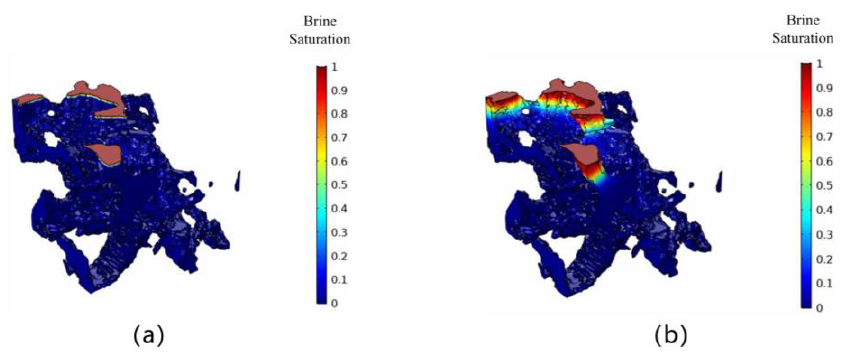
Figure 14. The tighter REV saturated with CO 2 ( a ) was initially saturated with brine in the near-inlet region with global target brine saturation of 0.05, ( b ) as prepared for the CO 2 –brine imbibition process over a range of target saturation from 0.2 to 0.9 with initial model conditions the same as in Section 4.2.